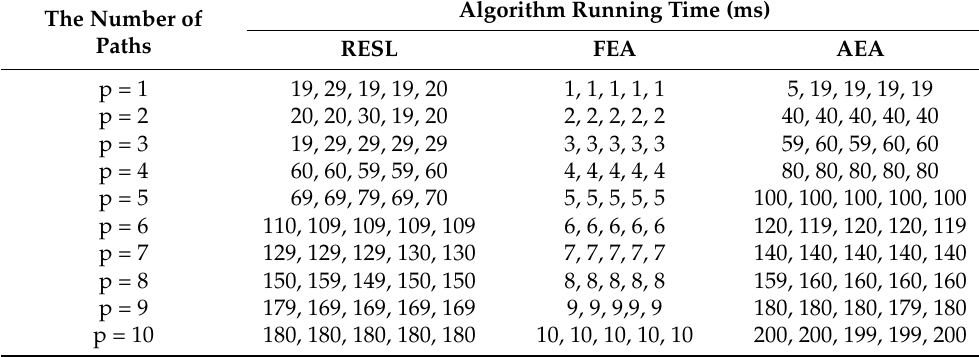
Table 2. Algorithm running